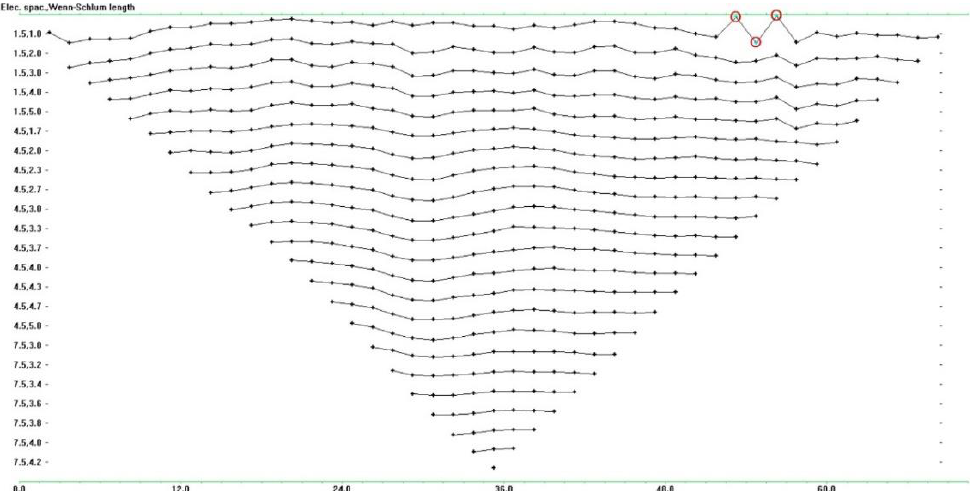
Figure 10. The distribution of bad data points (red circles) for the survey performed with the Wenner–Schlumberger array.